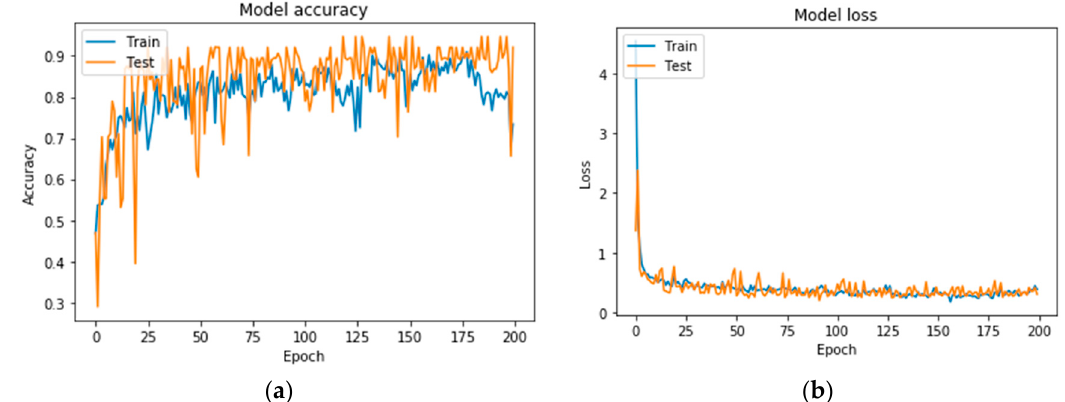
Figure A1. Precision curves for VGG16: ( a ) accuracy and ( b ) loss.